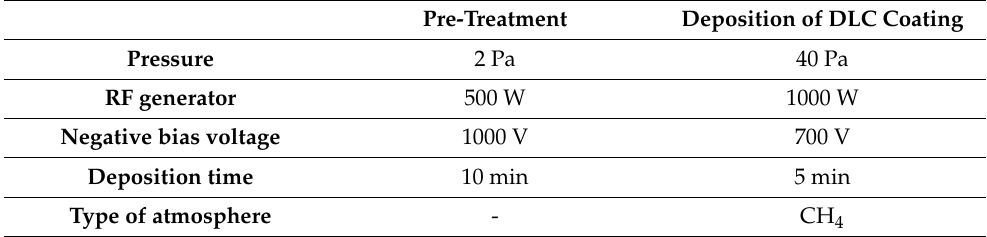
Table 3. Basic parameters of pre-treatment and DLC coating deposition process.